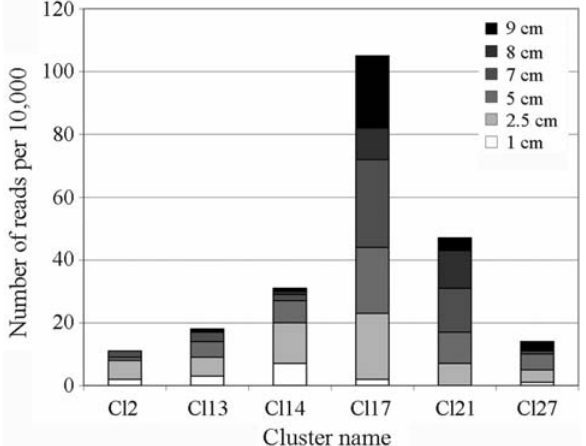
Figure 2 - Gene expression of terpene synthases in fruits. The most ex- pressed terpene synthases found in fruits were evaluated for their expres- sion pattern in fruit development. The number of reads for each transcript was counted for each of the libraries prepared, which represent different developmental stages. The reads were counted and normalized for 10,000